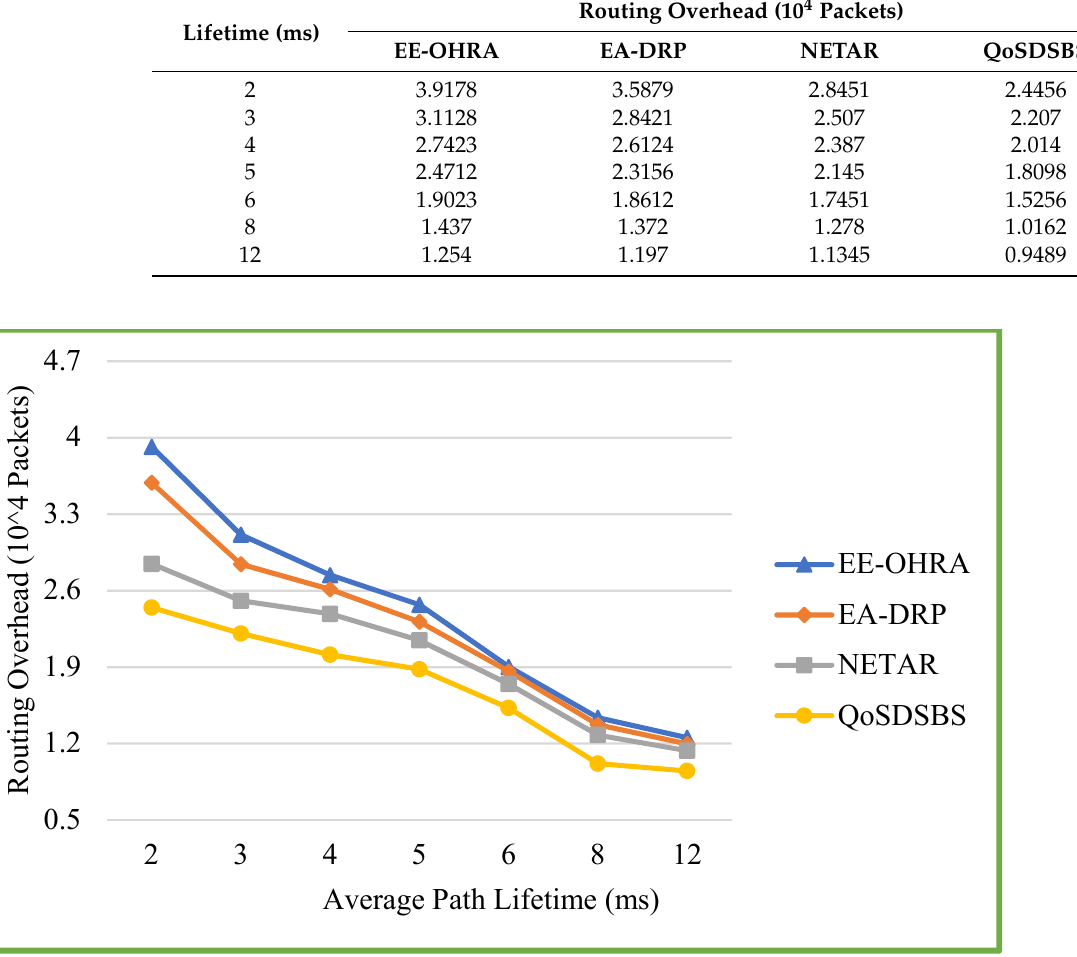
Figure 8. Average path lifetime vs. routing control overload. Table 5. Results of average path lifetime vs. routing control overload.